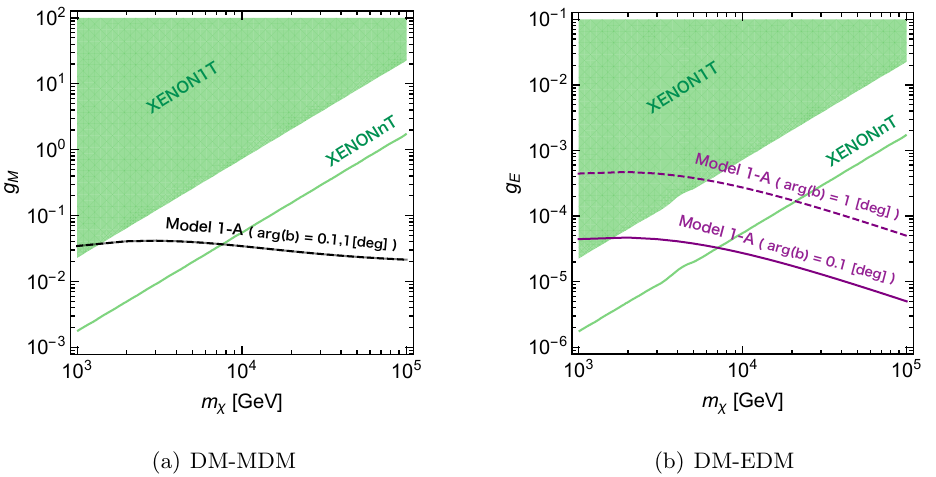
Figure 7 . Current constraints from XENON1T [80] on the DM-MDM and DM-EDM as functions of the DM mass shown in the green shaded regions, as well as the sensitivity of XENONnT [81] in the green solid line. We also show values of g been shown in (cid:12)gure 2.